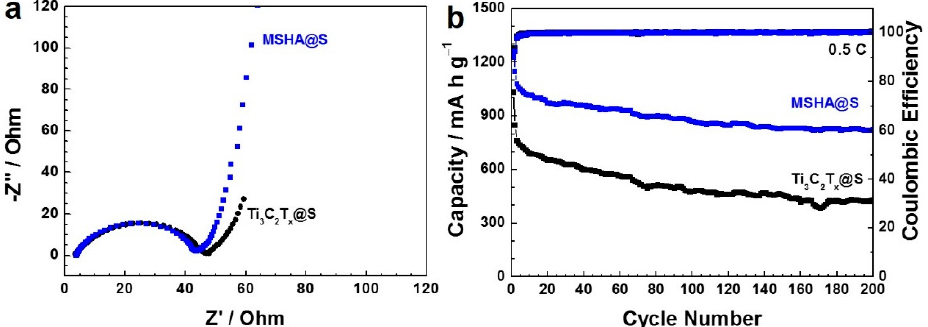
Figure 6. ( a ) Electrochemical impedance spectroscopy curves and ( b ) cycling stability (0.5 C) of the batteries with MSHA@S and Ti 3 C 2 T x @S cathodes. batteries with MSHA@S and Ti 3 C 2 T x @S